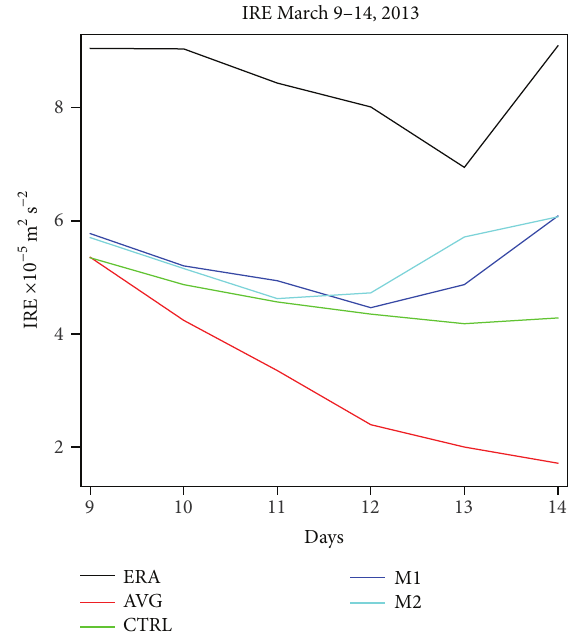
Shown are ERA reanalysis (black), GEFS ensemble mean (red), GEFS control (green), and two other ensemble members (dark and light blue).